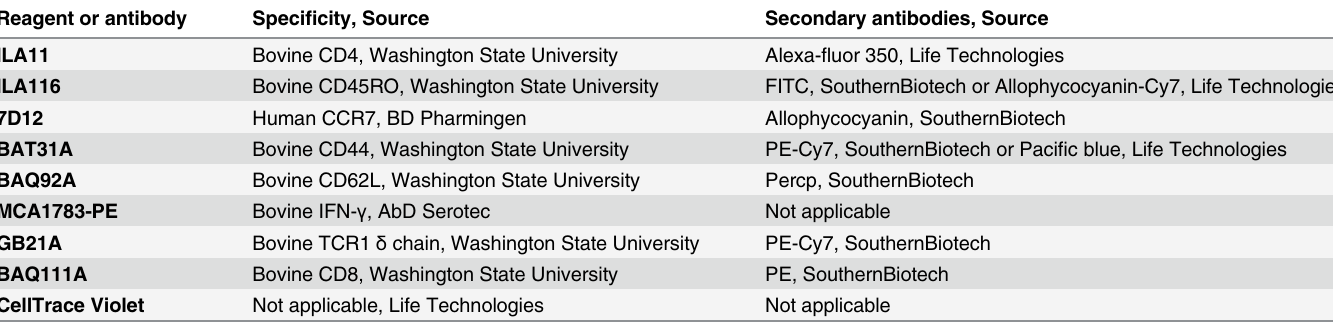
Table 1. Primary and secondary monoclonal antibodies and proliferation staining